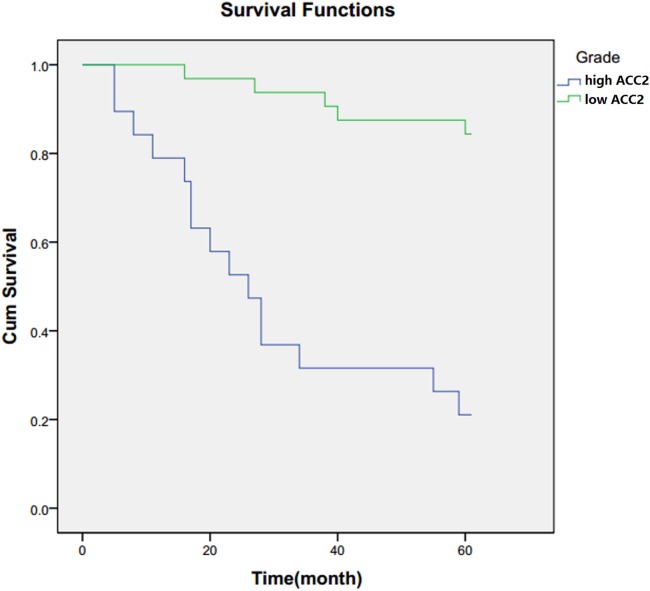
Association of patient survival with ACC2 expression level.Kaplan–Meier curves of 5-year survival among patients with laryngocarcinoma based on the expression level of ACC2. The green line represents the group of patients with low ACC2 expression, and the blue line represents the group of patients with high ACC2 expression.